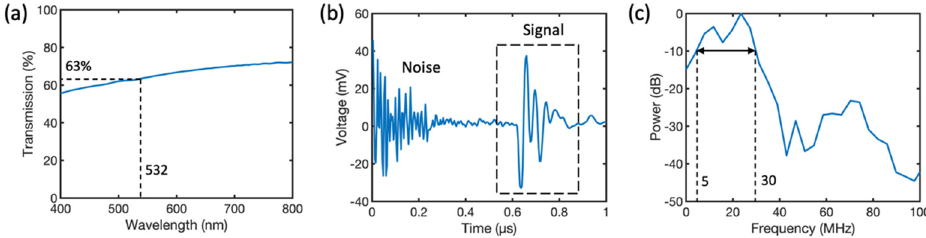
Figure 3. Optical and acoustic characteristics of the transparent ultrasound sensor. ( a ) Light trans- mittance through the PVDF − ITO thin film. ( b ) Detected photoacoustic signal from a black tap placed ~1 mm away from the transparent ultrasound sensor and the trigger-induced noise. ( c ) Power spectrum of the detected photoacoustic signal (in the dash box in ( b )).